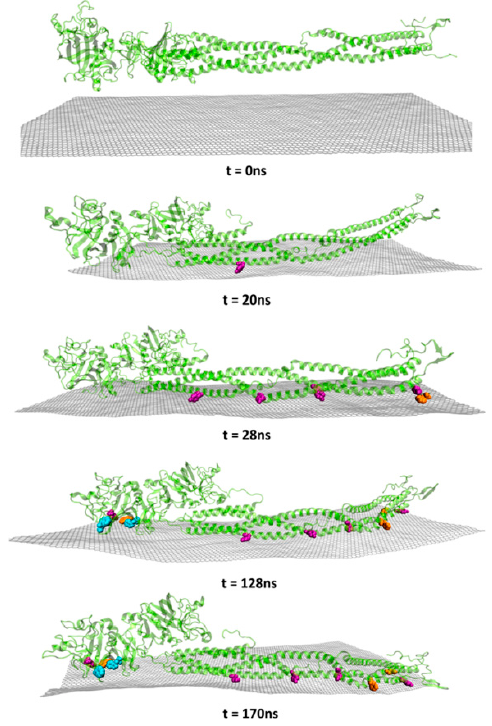
Figure 11. Simulated molecular adsorption dynamics of bovine Fng onto graphene surfaces. After initial contact, Fng molecules rearrange on the graphene surface due to hydrophobic interactions. The aromatics rings of protein amino acid residues Tyr (purple), Phe (orange), and Trp (blue) align with the graphene surface facilitating π - π stacking interactions. Reproduced with permission from [200].